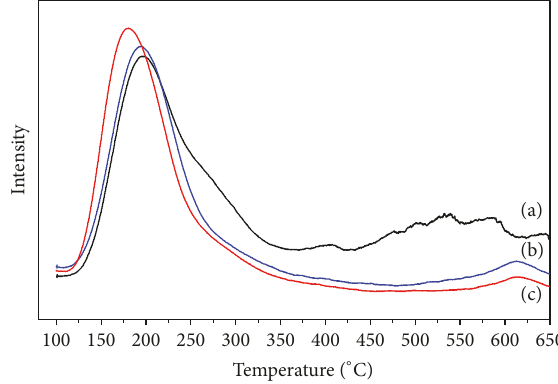
Figure 7: NH 3 -TPD profiles of fresh and reused NaY catalysts. (a) Fresh NaY; (b) NaY after used for the first time; (c) NaY after used for the second time.